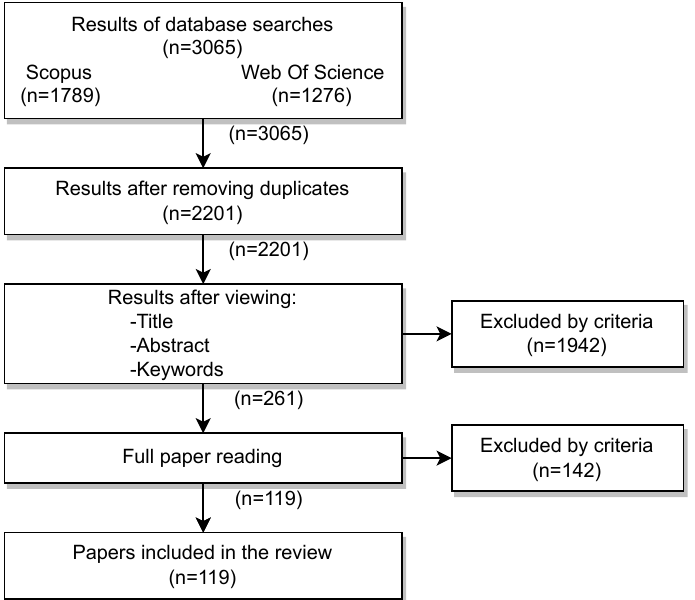
Figure 3. PRISMA flow